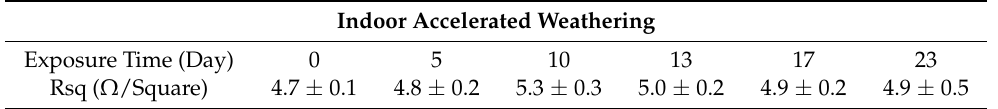
Table 2. Sheet resistance values of OMO samples before and after indoor accelerated weathering tests.